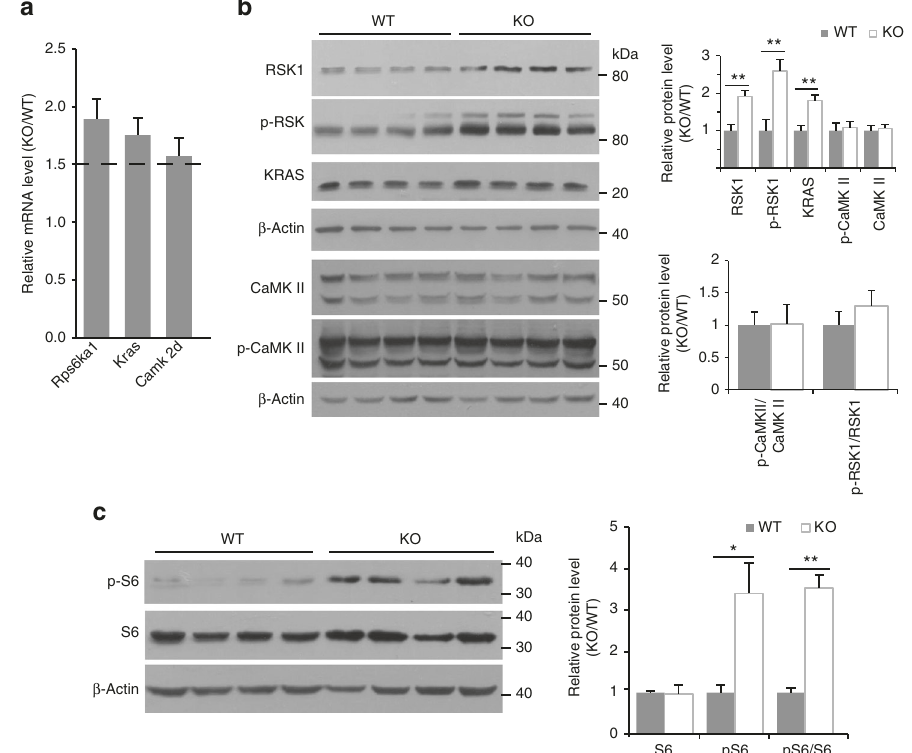
Fig. 3 Loss of Phf8 over activates mTOR signaling pathway in the hippocampus. a Shown is the relative mRNA expression of Neurotrophin and LTP associated genes in PHF8-de fi cient hippocampus, which is tested by real-time PCR and normalized to WT control ( n = 5). The dotted line indicated that 1.5-fold change in mRNA level of KO mice compared to WT mice was used as a threshold. b Western blotting con fi rms the upregulation of RSK1, phosphorylated RSK1, and KRAS expression in Phf8 -de fi cient hippocampus at the protein level. The statistical quanti fi cation is shown in the right panel ( n = 4). c The hyperphosphorylation of ribosomal S6 in Phf8 mutant mice is revealed by western blotting ( n = 4). The statistical quanti fi cation is shown in the right panel. * p < 0.05 or ** p < 0.01 vs. wild